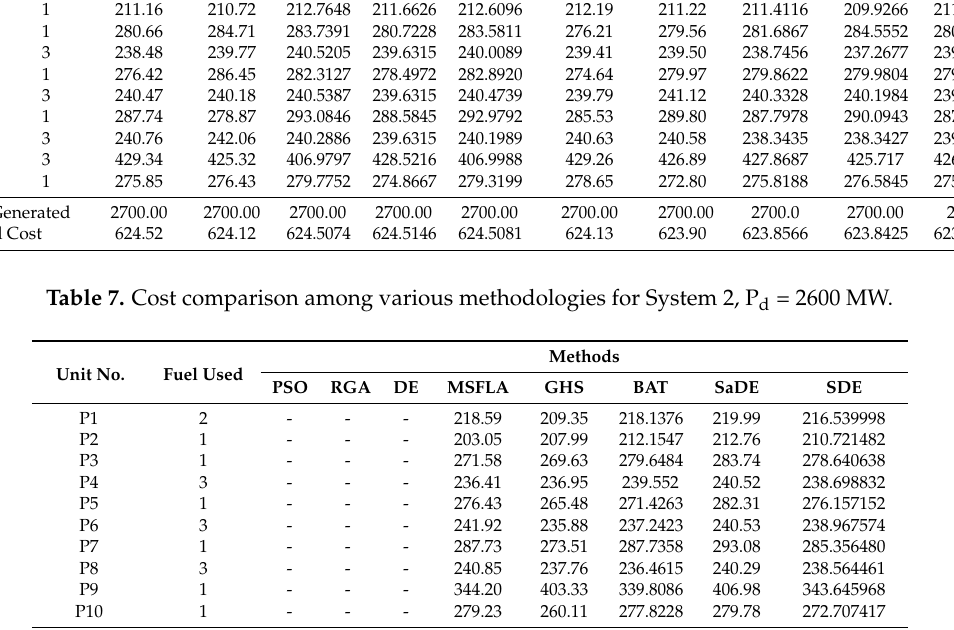
Table 6. Cost comparison among various methodologies for System 2, P d = 2700 MW. Unit No.